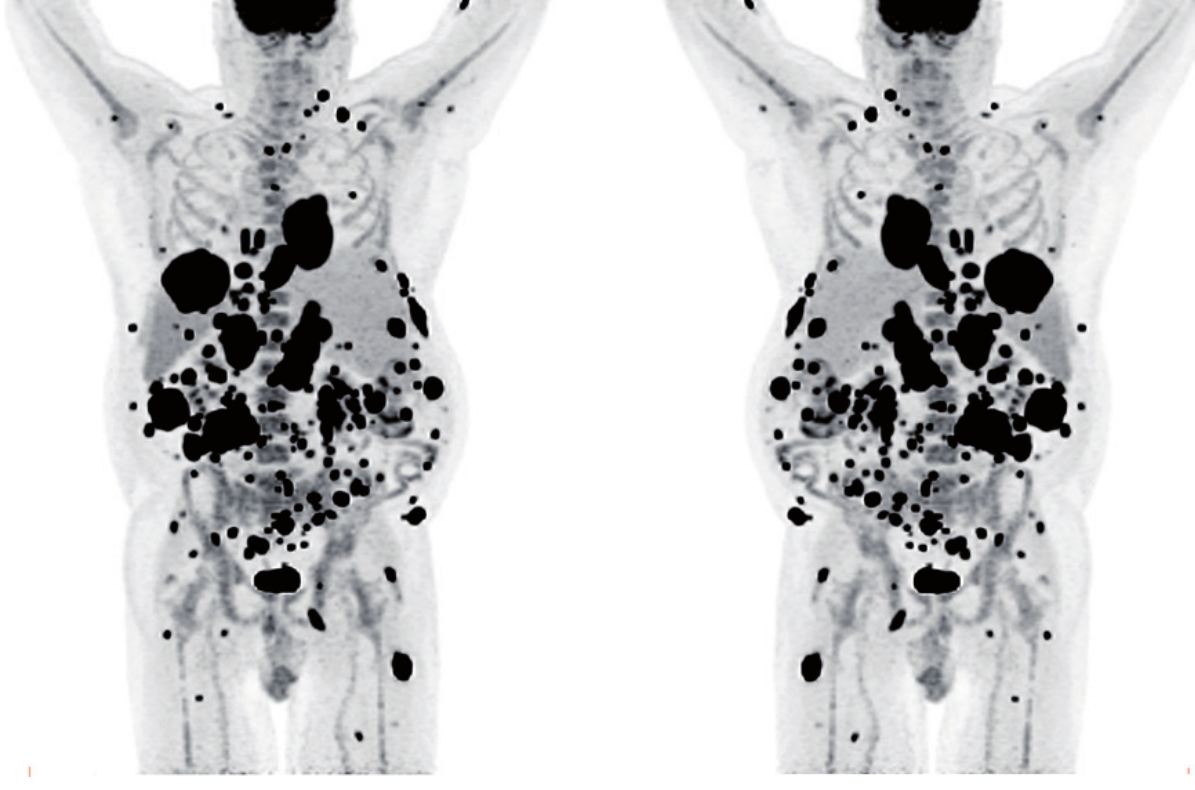
Figure 1. Maximum intensity projection (MIP) images in anterior and posterior views of the 18 F-FDG PET/CT images showing multiple hypermetabolic foci of increased FDG uptake throughout the body, most likely representing widespread metastatic